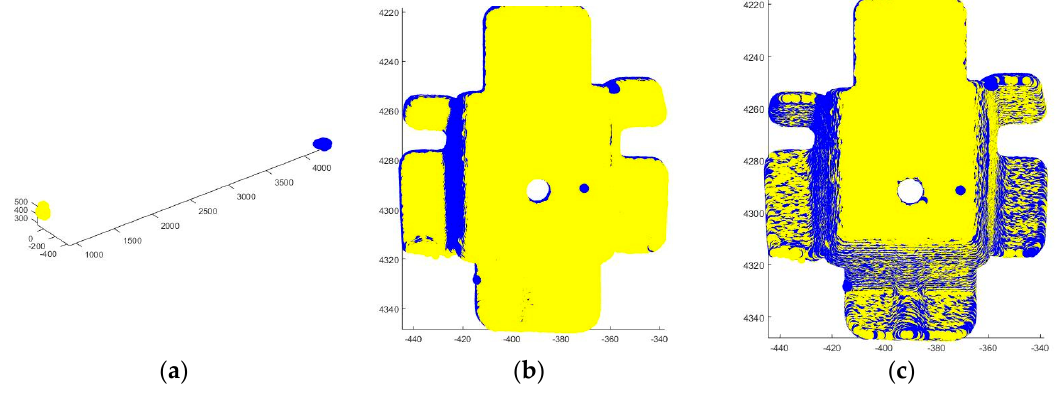
Figure 16. PCD after registration in Figure 10g . ( a ) is the initial position of the point cloud, ( b ) is the result of coarse registration, and ( c ) is the result of fine registration.